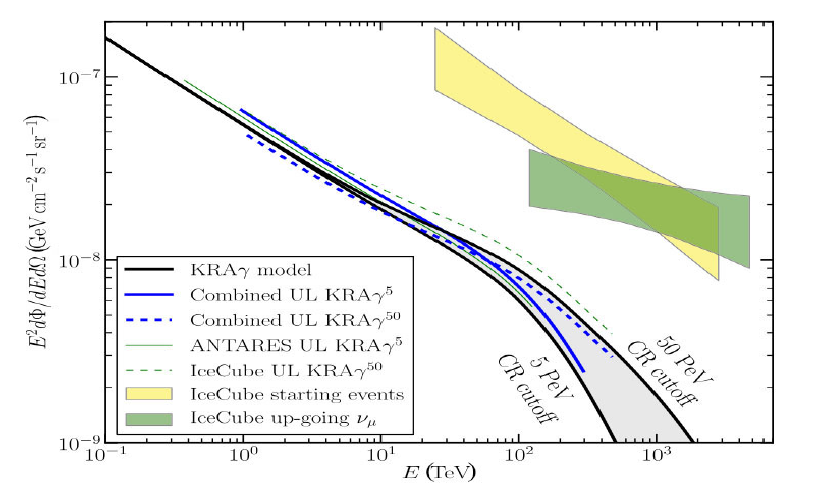
Figure 3. ANTARES and IceCube combined upper limit (UL) on a diffuse neutrino flux from the galactic plane (blue) and expected neutrino flux according to the KRA γ model [15] (black). The boxes represent the isotropic astrophysical neutrino fluxes measured by IceCube using starting events (yellow) and up-going tracks